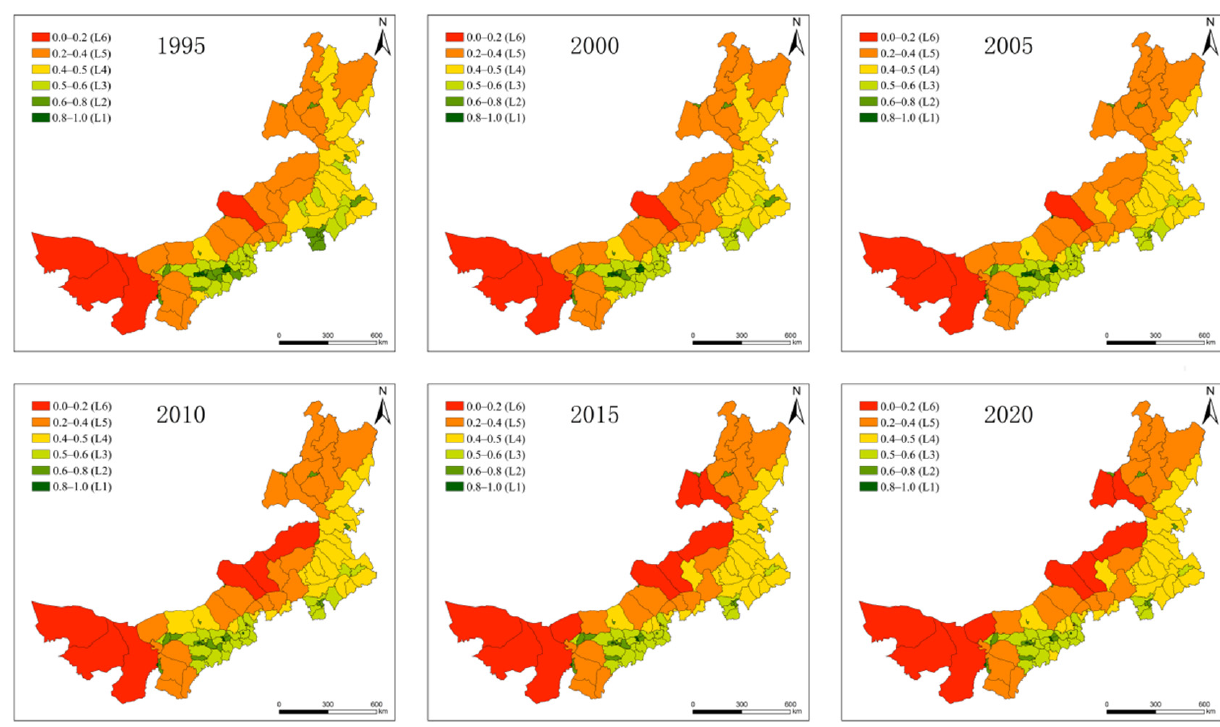
Figure 7. Spatial pattern of CCD in Inner Mongolia. Figure 8 illustrates the average coupling coordination value of temporal scale varia- tions in 101 counties from 1995 to 2020, which shows the coordination level of each county except for Alxa county. Since Alxa’s temporal changes from 1995 to 2020 are not significant, we excluded them from Figure 8. The CCD values in approximately 66% of the counties exhibit a fluctuating downward trend. Located primarily in city centers and surrounding areas, these counties are mostly concentrated in the regions with the highest level of eco- nomic development and urbanization. Because of rapid industrialization and urbanization, land use patterns are largely disordered (construction land increases, and forestland and grassland decrease) and natural ecosystem foundations are changed, which adversely im- pacts the supply of core ESs. In contrast, the CCD changes in 23% of the counties showed an upward trend, including Chahar Right Front Banner, Dengkou, Dongsheng, Dong Ujimqin,